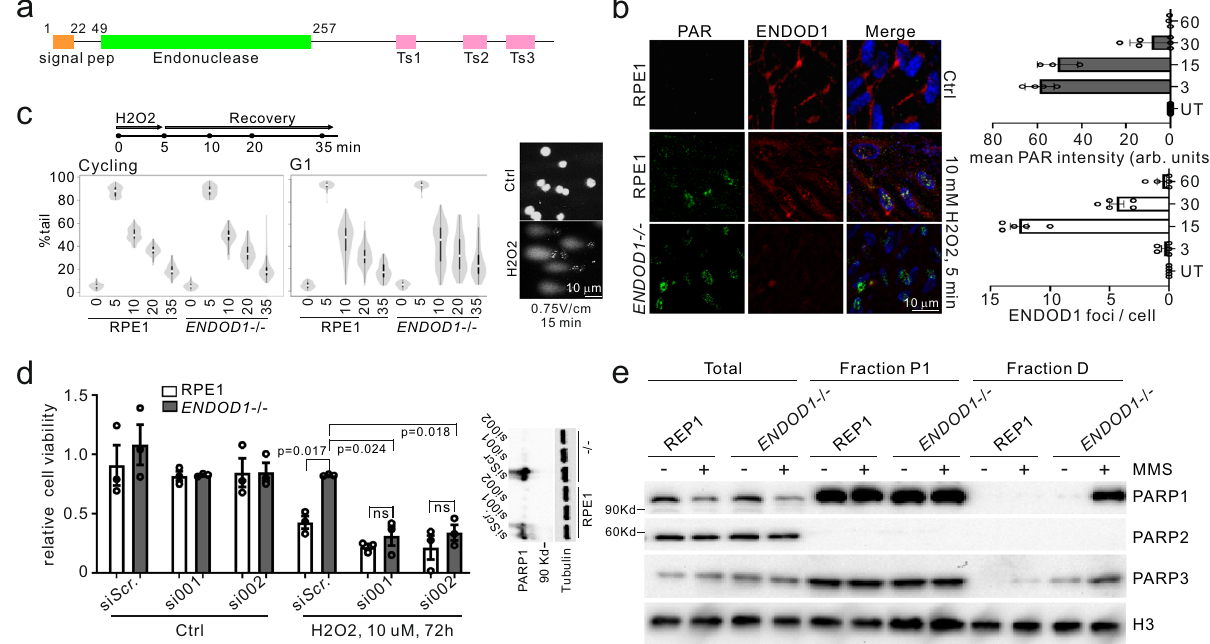
Fig. 1 Characterization of ENDOD1 in DNA repair. a Schematic of ENDOD1 protein showing the predicted signal peptide (residues 1 – 22), the endonuclease domain (residues 49 – 257) and three C-terminal transmembrane motifs (Ts). b Left: Representative indirect immuno fl uorescence images for α -ENDOD1 (ABclonal) and α -PAR: untreated RPE1 cells (top row), RPE1 and ENDOD1 − / − cells after a 5 min treatment with 10 mM H2O2 (bottom two rows). For the merged panels nuclear DNA was counterstained with DAPI. Right: quanti fi cation for nuclear signals at the indicated time points after H2O2 treatment. arb. units: arbitrary units. n = 3 – 5 biologically independent experiments. c Comet assay to assess repair ef fi ciency. Left: quanti fi cation of tail moments from three repeats for proliferating RPE1 and ENDOD1 − / − cells at the indicated time points after H 2 O 2 challenge ( p = 0.197 for RPE 35v ENDOD1 − / − 35, Kruskal test). Middle: tail moments from 150 cells from each of 3 biologically independent experiments for serum-starved G1 arrested RPE1 and ENDOD1 − / − cells at indicated time points after H2O2 challenge ( p = 0.787 for RPE1 20 v ENDOD1 − / − 20; p = 0.0000159 for RPE1 35v ENDOD1 − / − 35, Kruskal test). Right: representative images of alkaline comet assay. Percentage tail moment was calculated by dividing the pixel intensity of tails by that of heads. White dot: median. Thick whisker: third quartile. Thin whisker: upper/lower adjacent values (1.5x inter-quartile range). d Relative viability of RPE1 or ENDOD1 − / − cells treated with two different si PARP1 (si001 and si002) 48 h before challenge, with or without continuous H2O2 treatment (10 μ M). Assay: CCK8 colorimetry. Inset showing the knockdown ef fi ciency of each siRNA. n = 3 biologically independent experiments. Signi fi cance test: two-tailed Student ’ s t test. p values: 0.0057, 0.047. ns: not signi fi cant. e . Whole-cell extract (total), nuclear extracts (P1) and MNase-digested extract (fraction